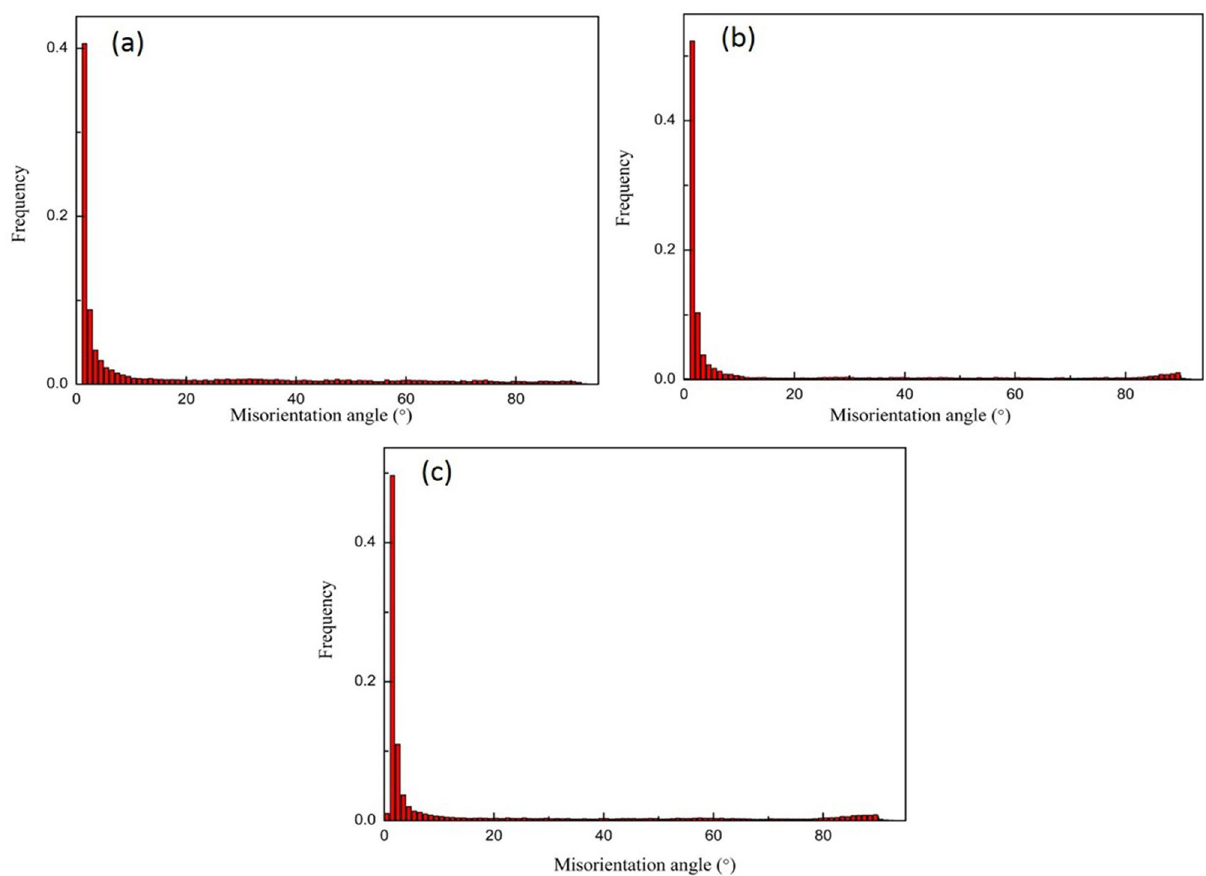
Figure 5. Distribution of orientation difference of Mg–2Y–0.6Nd–0.6Zr alloy after ECAP at different rolling temperatures. ( a ) ECAP4passes, ( b ) ECAP4Passes + rolling, ( c ) ECAP4Passes + liquid